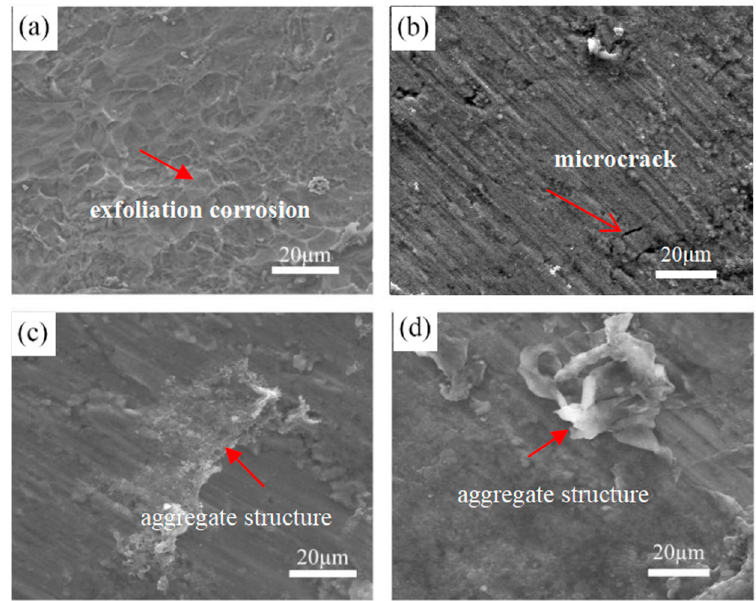
Figure 12. Morphology of coating after testing of potentiostatic polarization in simulated environment of PEMFCs. ( a ) Bare Ti; ( b ) Carbon film; ( c ) C-PTFE/GS; ( d ) C-PTFE/GS-CNT.